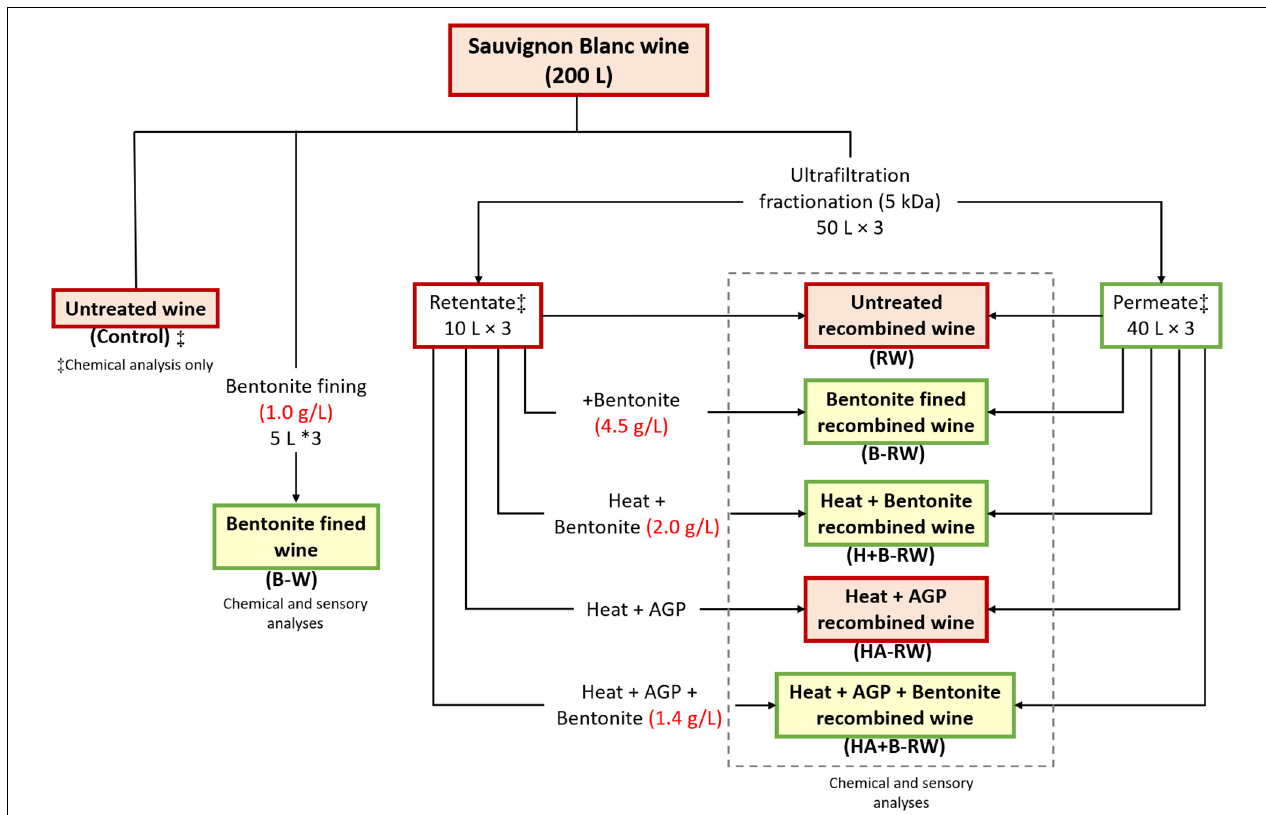
FIGURE 1 | Flowchart of Sauvignon Blanc wine treatments and codes. Retentate heat treatment was 10 min at 62 ◦ C and Aspergillopepsin (AGP) protease dosage was 0.05% v/v DSM, if applied. Red boxes represent samples that were heat unstable ( (cid:49) NTU > 2), while samples in green boxes were heat stable ( (cid:49) NTU < 2). ‡ Denotes samples that were subject to chemical analysis only. Chemical and sensory analyses were performed on all other wine